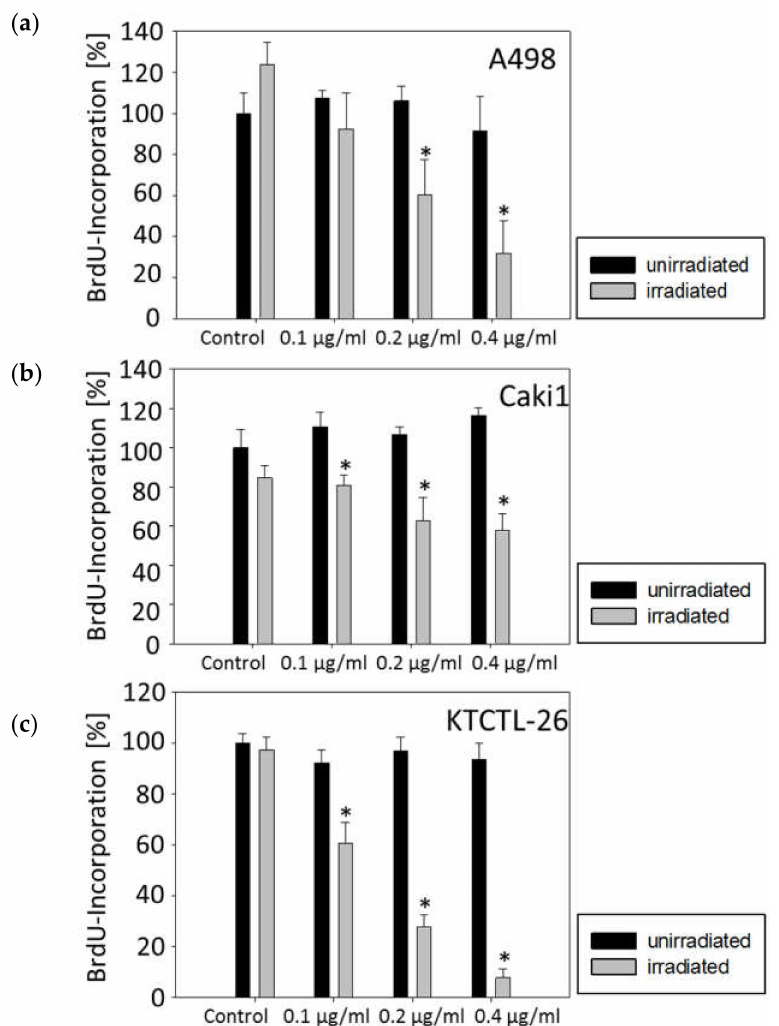
Figure 3. Cell proliferation in A498 ( a ), Caki1 ( b ), and KTCTL-26 ( c ) cells cultured with 0, 0.1, 0.2, and 0.4 µ g/mL curcumin without (black bars) or with irradiation (grey bars). Irradiation was done with 5500 lx visible light for 5 min. Tumor cells were then subjected to the BrdU incorporation test following a further 24 h incubation in cell culture medium without curcumin. BrdU-incorporation is expressed as percentage of the untreated cells. Each experiment was done in triplicate and repeated five times. Data from one representative experiment are shown. * Indicates significant difference to